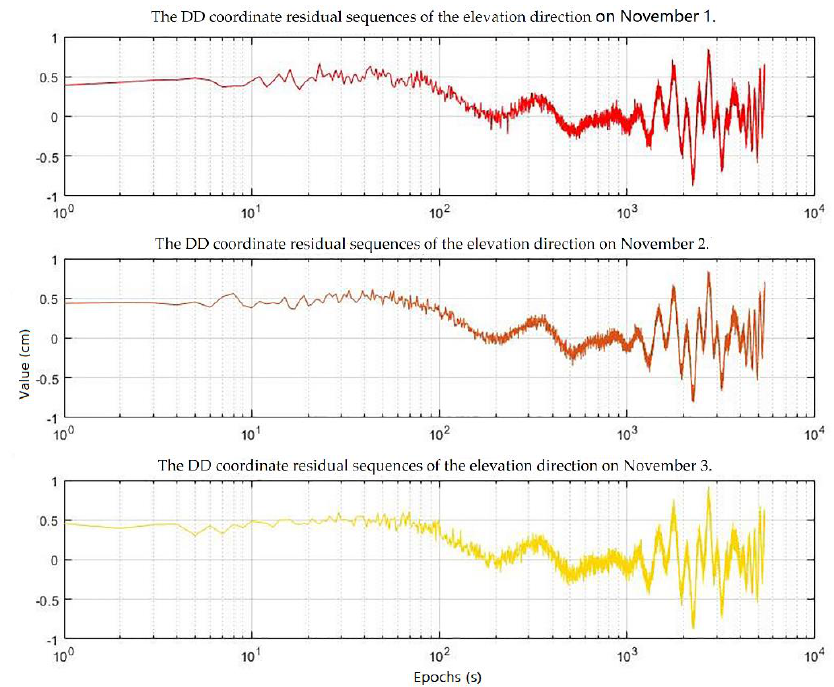
Figure 8. Original DD coordinate residual sequences of the elevation direction for the three consecutive days.